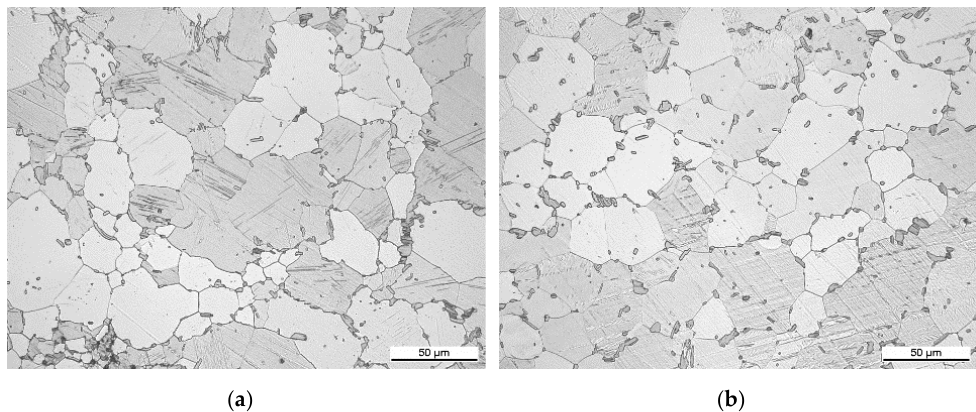
Figure 6. Micrographs of Mg-Dy-Nd-Zn-Zr alloy after heat treatment at 500 °C for ( a ) 0.5 h and ( b ) 1 h followed by cooling in air, showing LPSO lamellae within Mg matrix grains and blocky LPSO within the grain and at grain boundaries in different quantities.